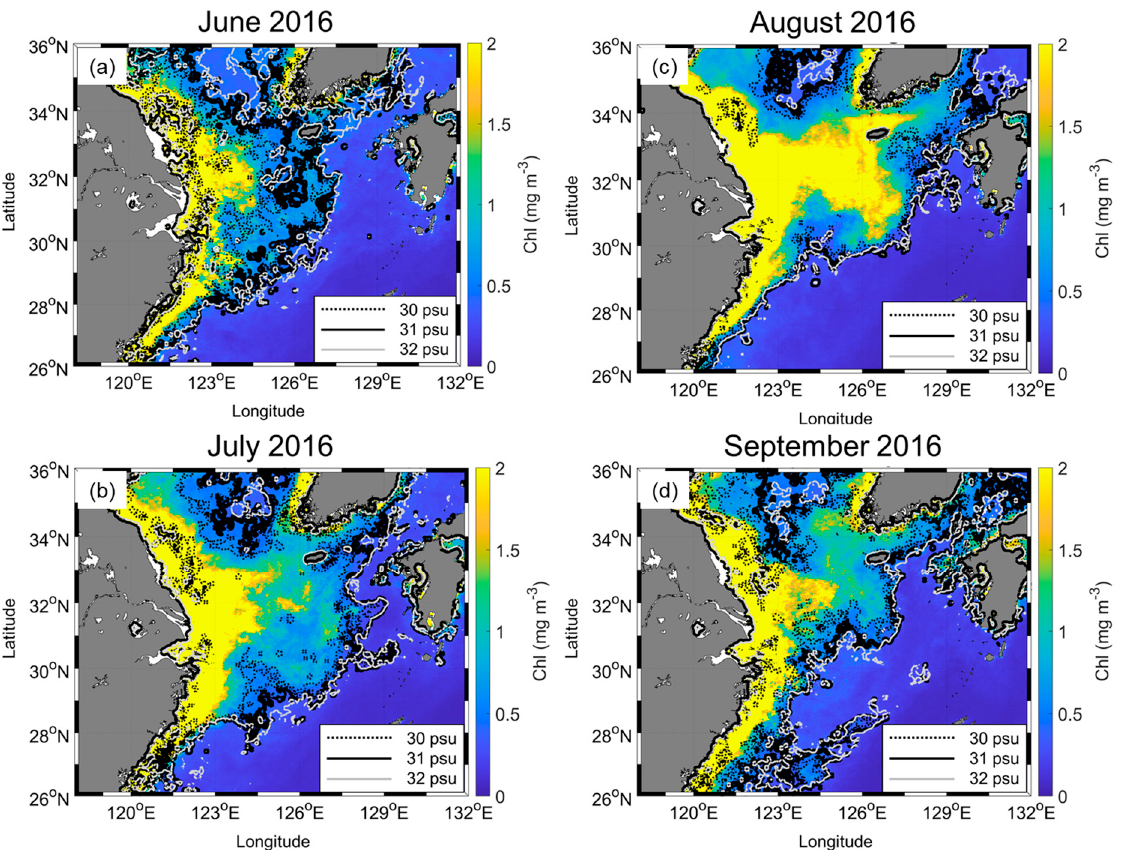
Figure 4. Monthly Chl (shown with color map) and cumulative SSS footprint (shown with contours) from ( a − d ) June to September 2016. The dotted and solid black and gray lines indicate 30, 31, and 32 isohalines, respectively.